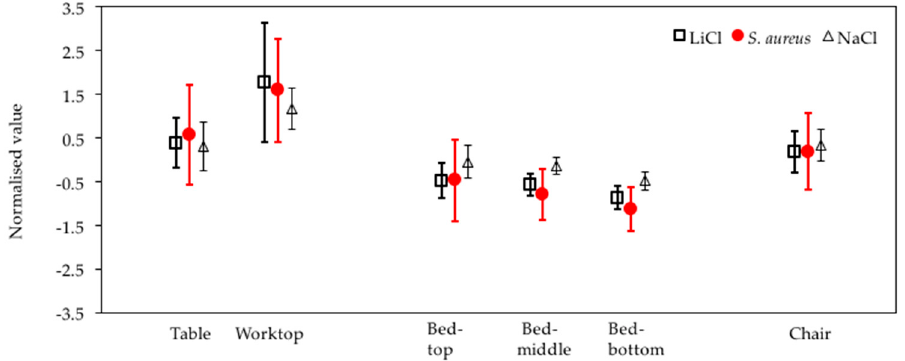
Figure 7. Comparison of normalized surface deposition for LiCl, NaCl and S. aureus. Error bars represent one normalized standard deviation units from the mean.